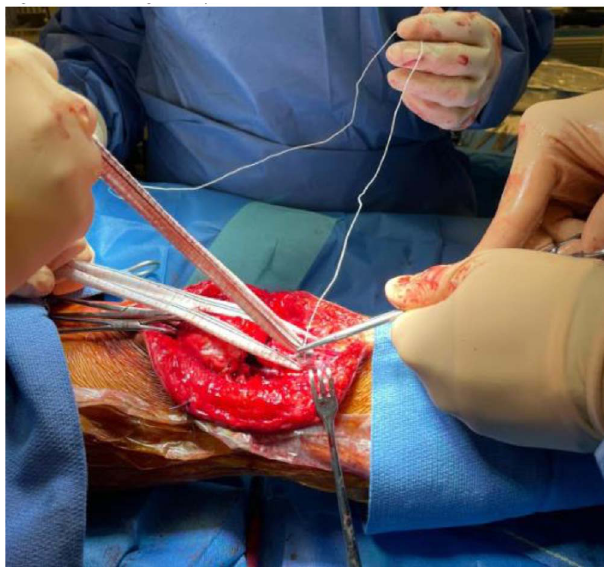
Figure 13. Reinforcement of the knot with non-absorbable sutures.